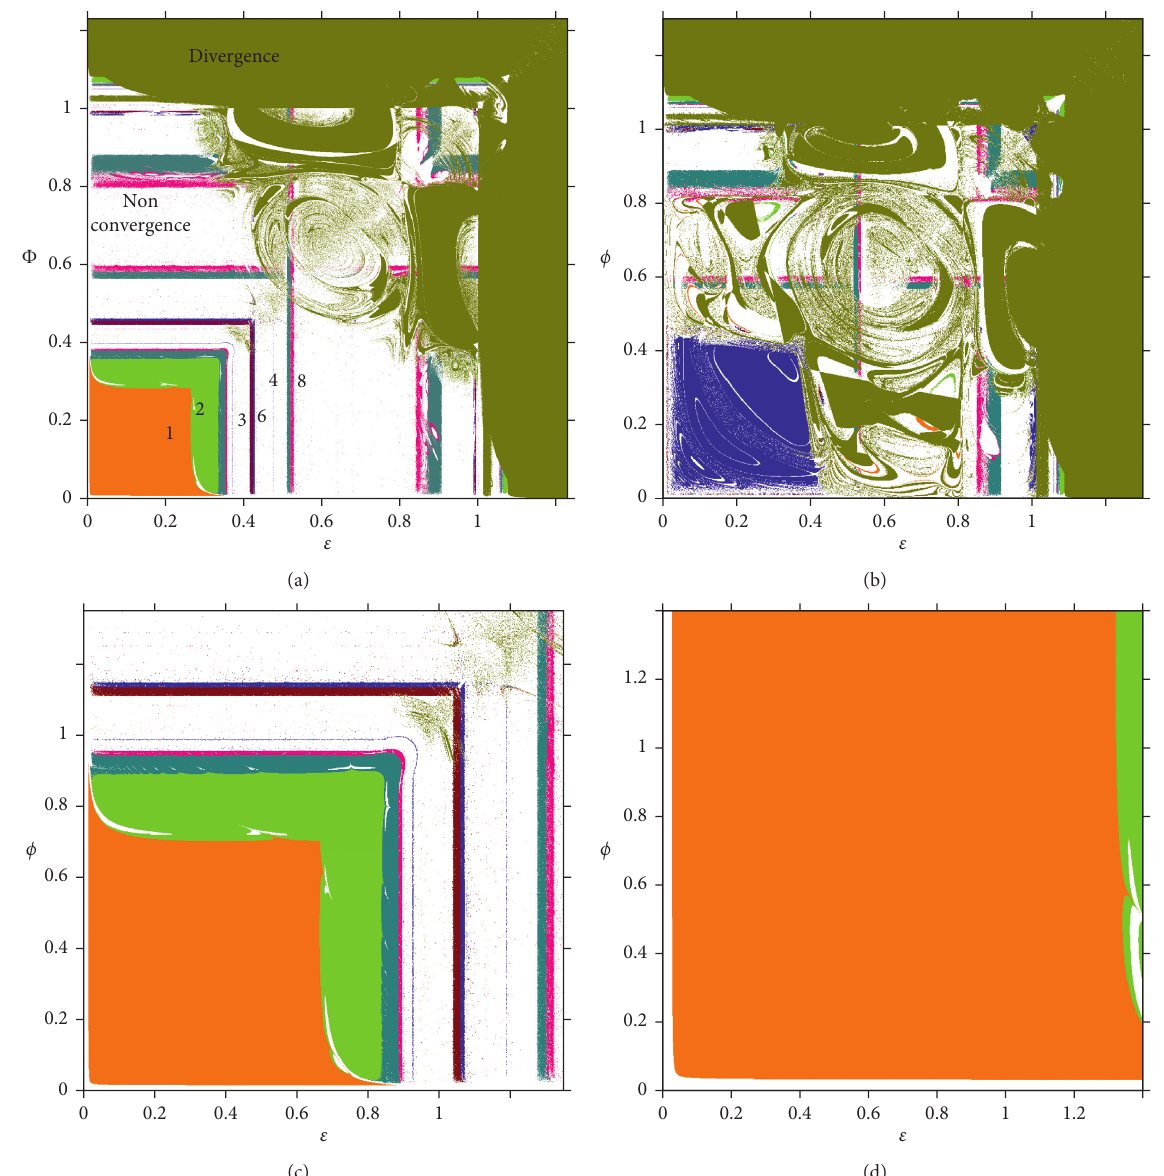
Figure 9: The parameter basin of robustness. (a) Con � 0, η � 0 . 3. (b) η � 0 . 9 � 0.9. (c) η � 0 . 9 � , Con � 0 . 6. (d) η � 0 . 9, Con � 0 .